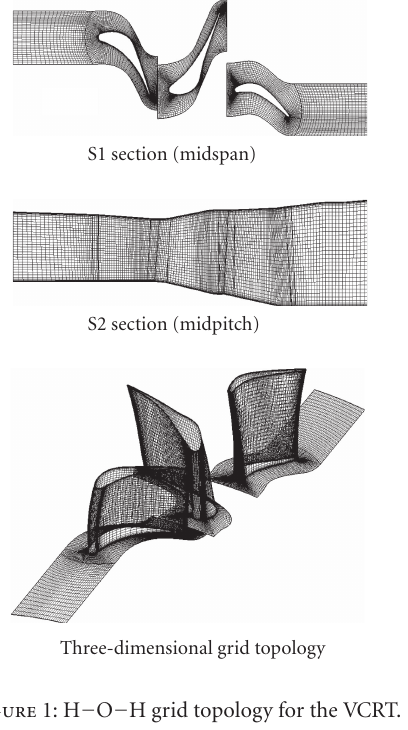
Figure 1: H − O − H grid topology for the VCRT.